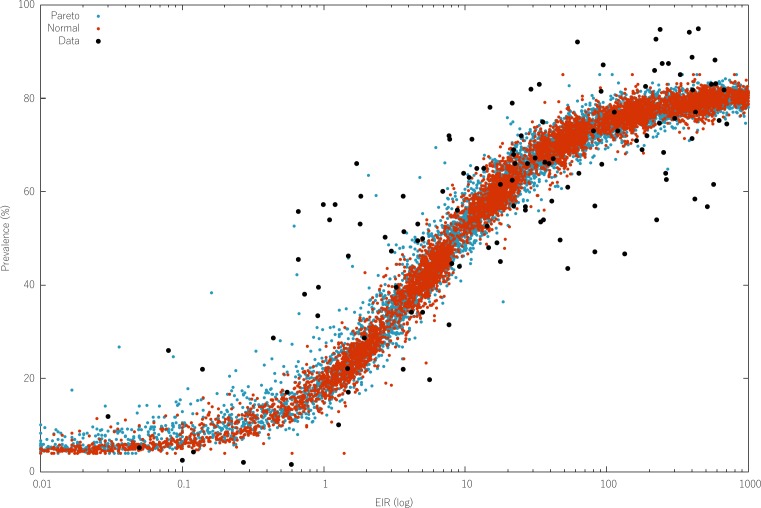
Calibrated relationship between EIR and Data.The black dots depict the data points in the Guerra et al. (2007) database. The colored dots show 100 thousand individual model predictions for the observable prevalence in a village (aggregated over 100 runs with 1000 villages each) with EIR given in the X-axis. These 100 runs scan the biting rate parameter space, increasing the mean biting rate in 1000 village for each run, until a desirable coverage of EIR values is obtained. Each color signifies a different distribution of how mosquito densities vary over space. The more extreme distribution (Pareto) displays a higher variance, more in line with that observed in the data, particularly for low EIR values. This is caused by population movement, with people living in these low EIR villages potentially being infected in very high EIR villages when they visit them.